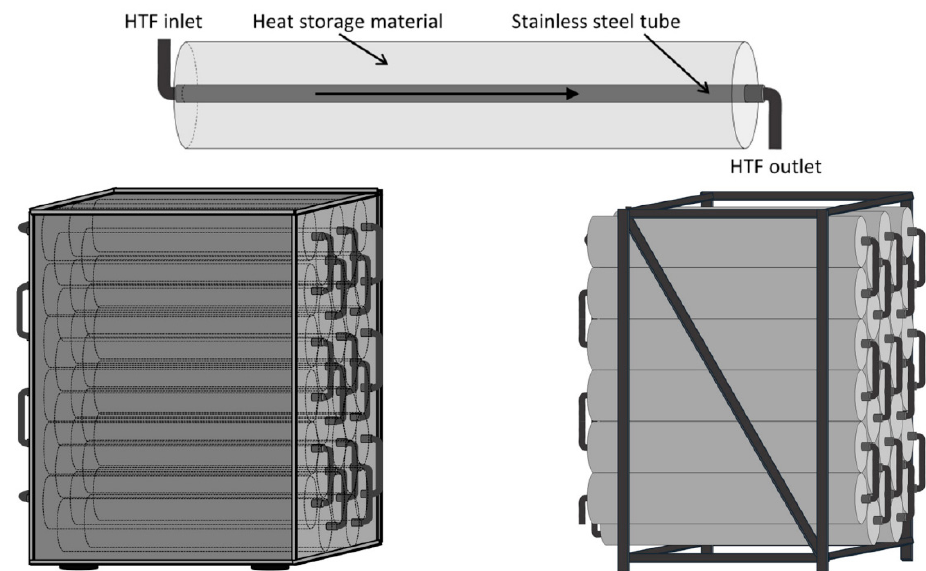
Figure 3. Schematic drawings of the tube surrounded by heat storage material for both LHTS and concrete storage ( top ), the LHTS system ( left ) and the concrete storage system ( right ) considered in this work. Both TES systems are represented without thermal insulation material.